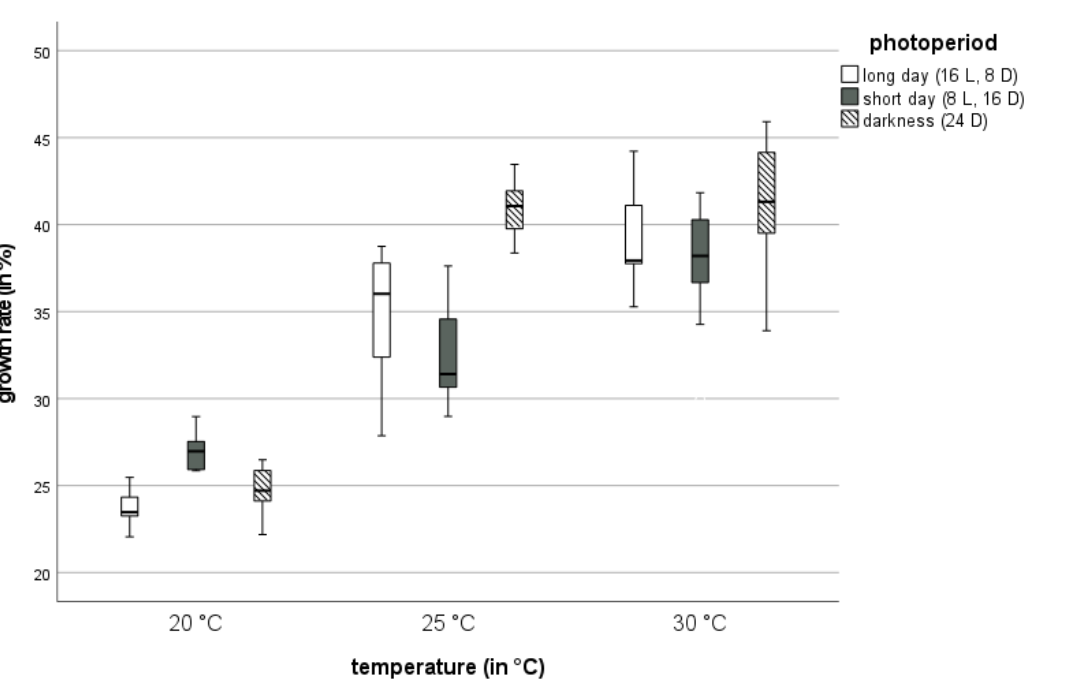
Figure 4. Mean growth rates (in %) of mealworms at three different temperatures (20 °C, 25 °C, and 30 °C), grouped by three photoperiods: long day (LD), short day (SD), and constant darkness